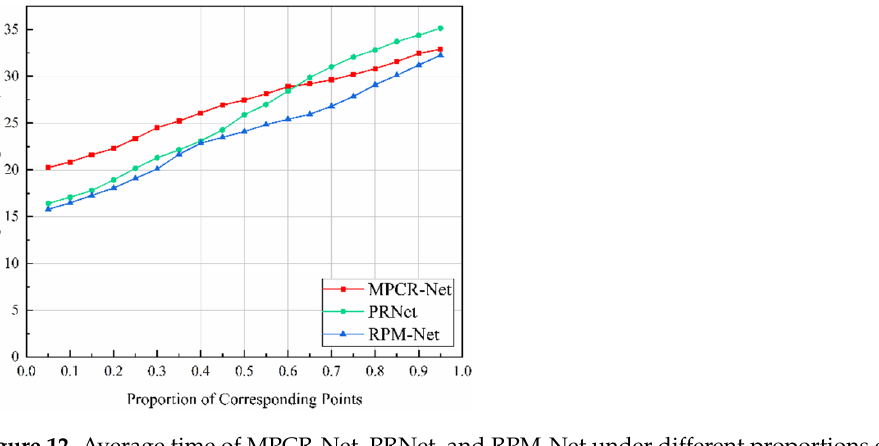
correspondence points. spondence points.